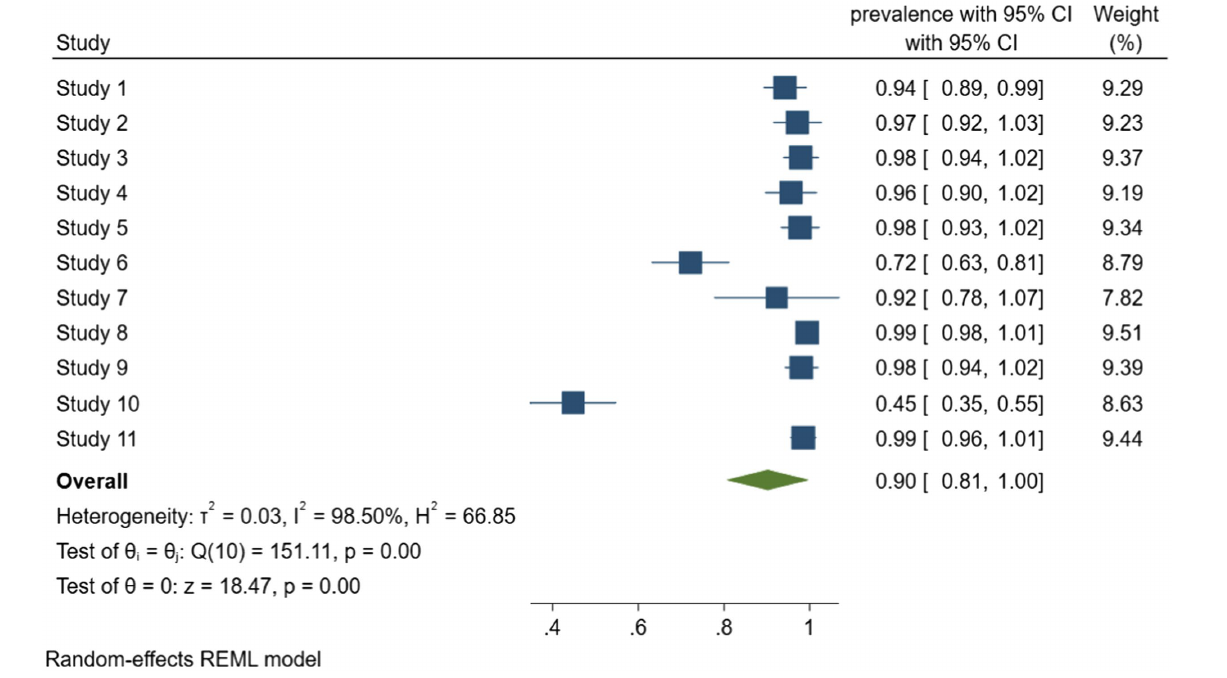
FIGURE 3 | Forest plot of the meta-analysis of biofilm formation rate in foodborne pathogen retrieved from food samples. Study 1: Lapierre et al. (2020). Study 2: Lopez-Leon et al. (2016). Study 3: Rodríguez-Lázaro et al. (2018). Study 4: Beshiru and Igbinosa (2018). Study 5: Beshiru et al. (2018). Study 6: Chen and